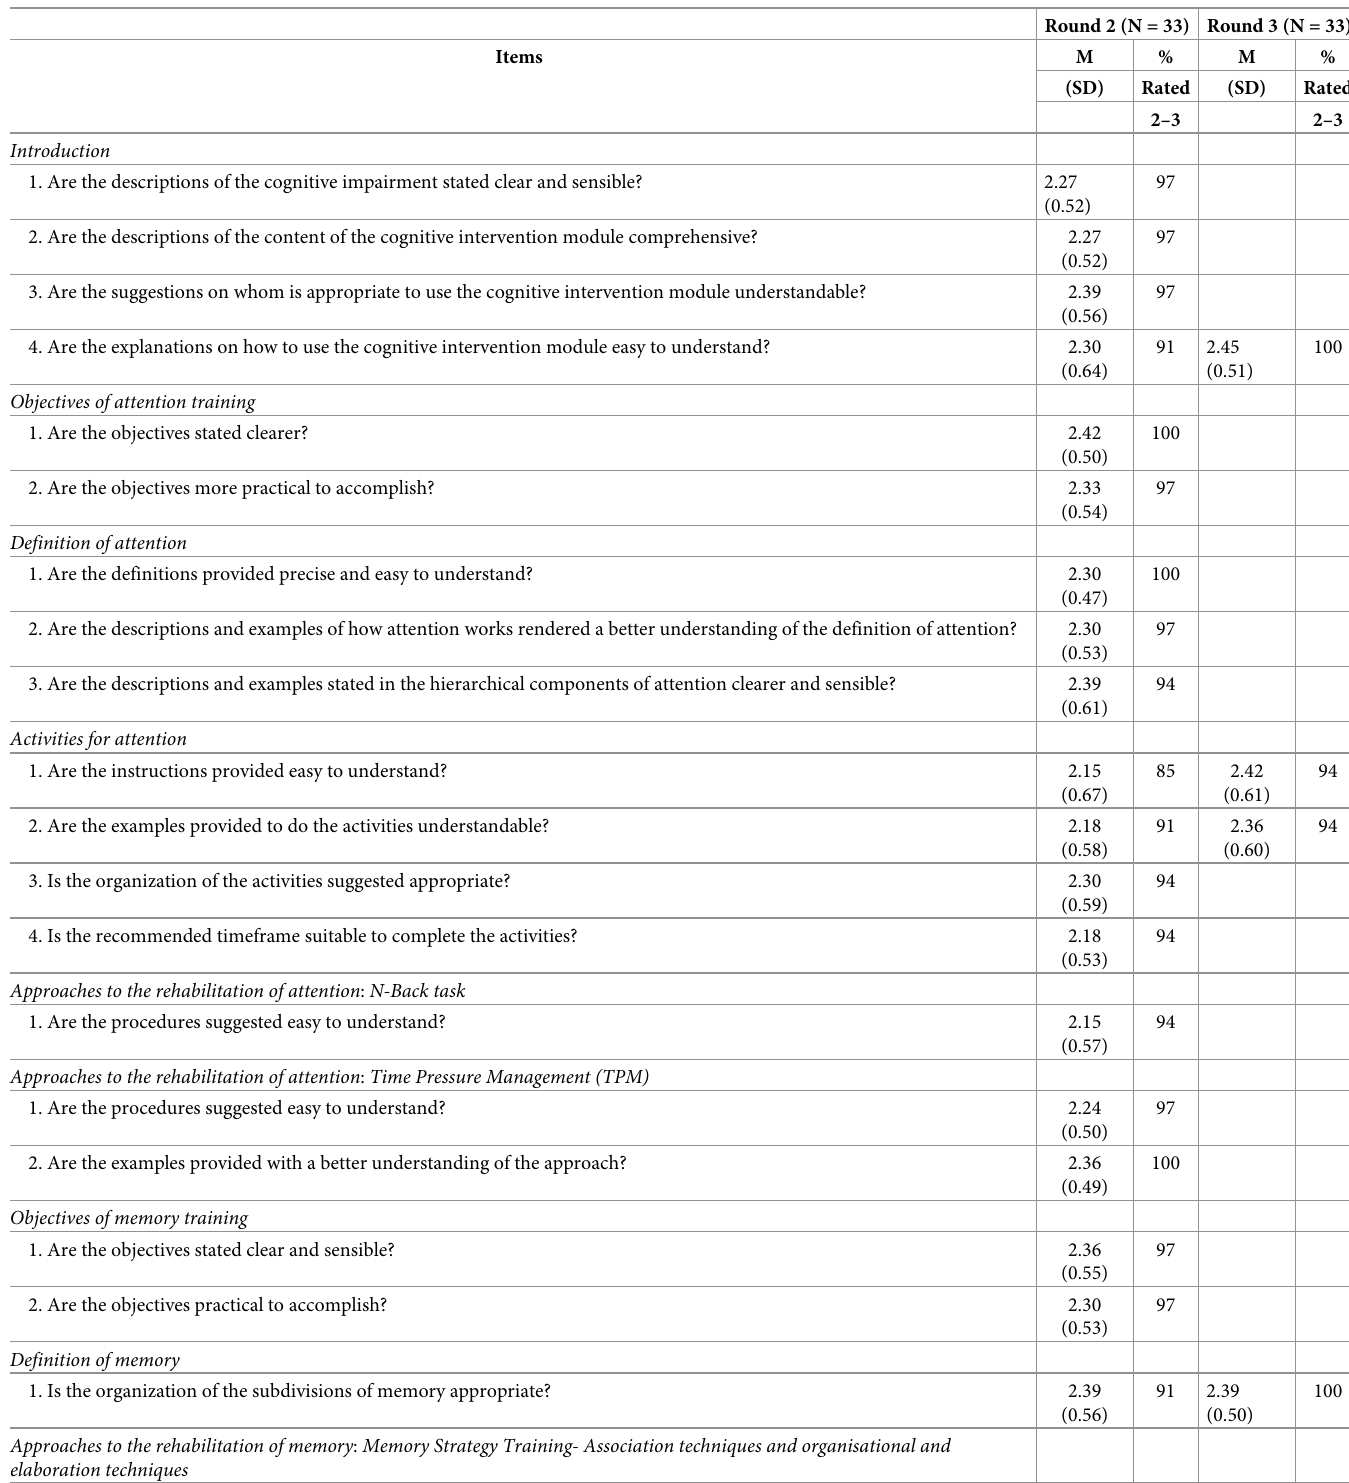
Table 4. Results from Delphi Round 2 and Round